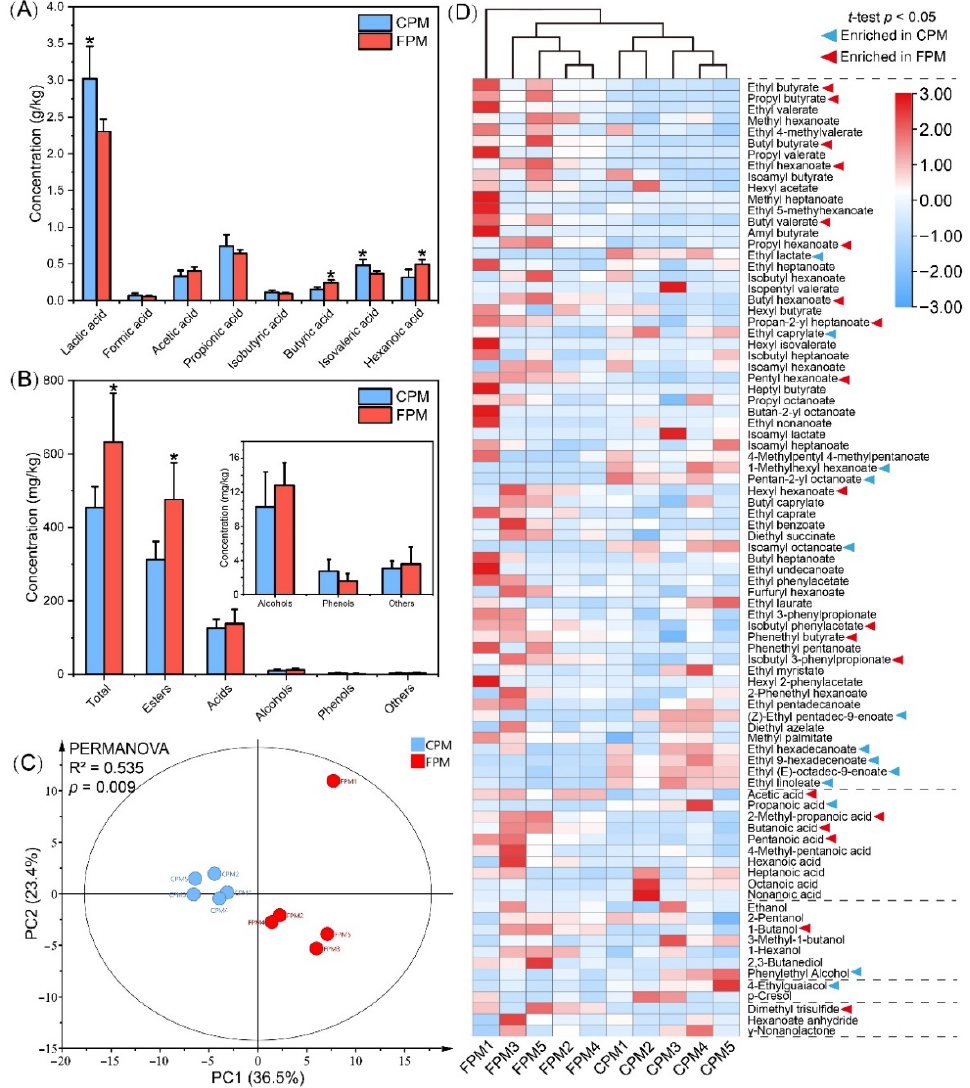
Figure 3. The concentration of major organic acids ( A ) and volatile compounds ( B ) in FPM and CPM, and the principal component analysis ( C ) and cluster heatmap analysis ( D ) of volatile compounds. * represents significant difference ( t -test, p < 0.05).